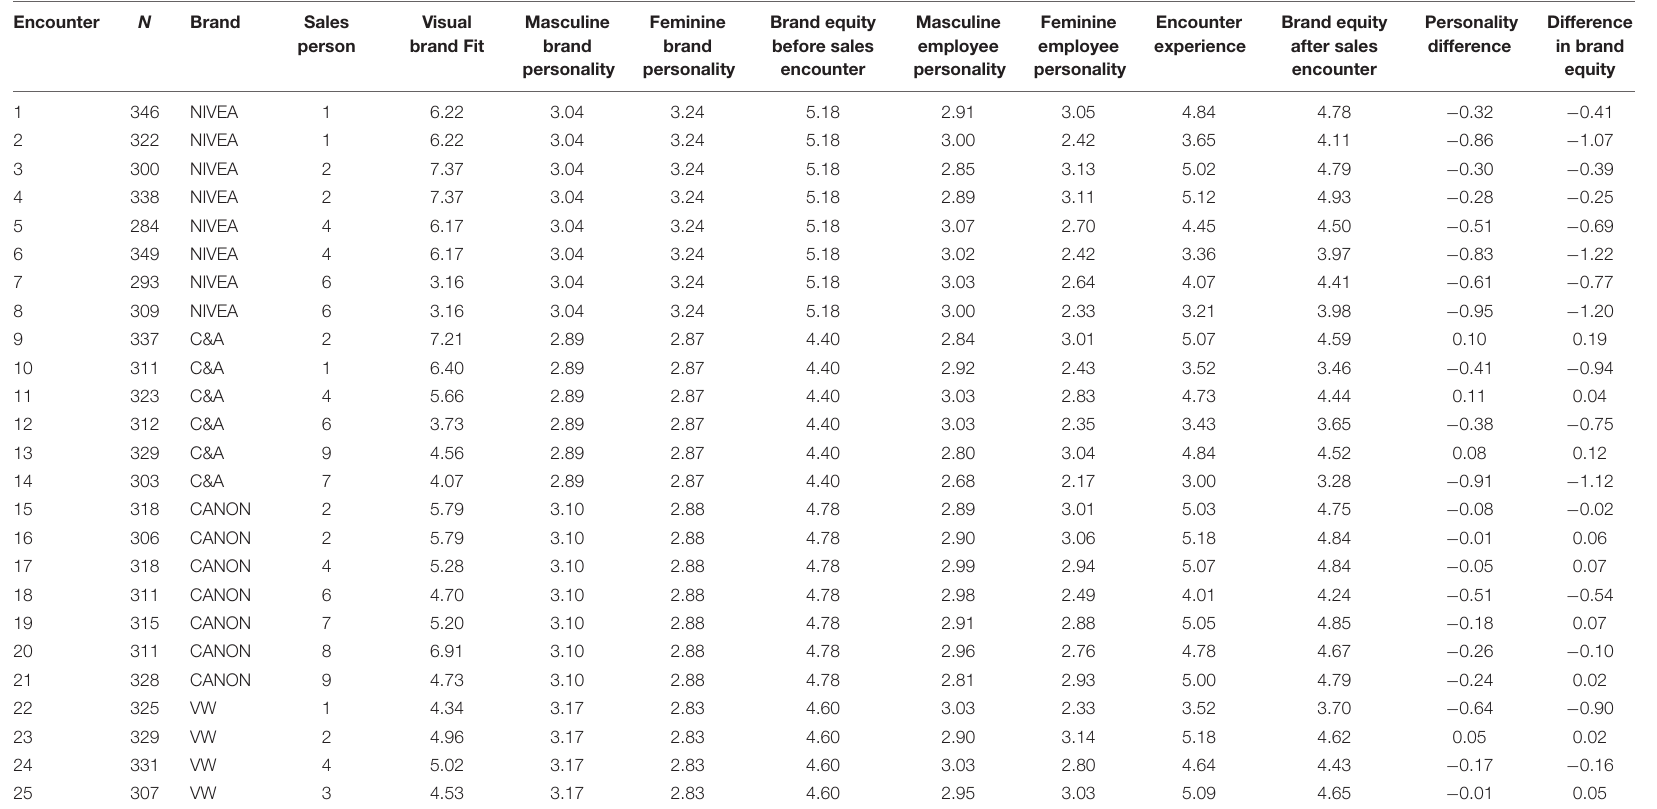
TABLE 3 | Brand equities before and after 48 sales encounters.